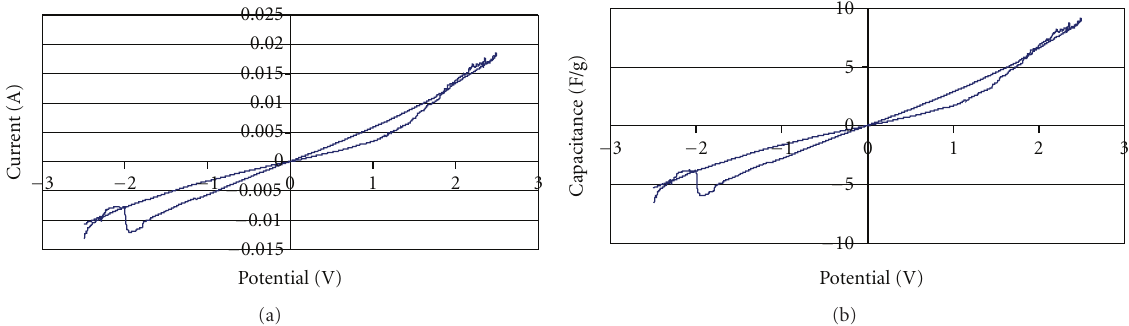
Figure 10: Cyclic voltametry of EDLC CWF-CNT-GF/F capacitor from − 2.5 to 2.5V at a rate of 0.2V/s and specific capacitance of electrode; each carbon electrode has an area of 1 cm 2 and mass of 20.2mg (20mg CWF and 0.2 mg CNTs).